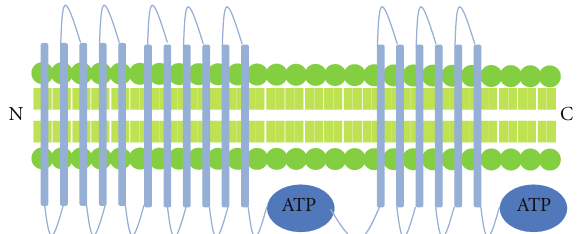
Figure 3: Structure of Multidrug Resistance Protein 1 (MRP1)— this ABC transporter is similar in structure to PGP in that they possess 2 ATP binding sites. In addition to the 12 transmem- brane domains, they also contain an additional 5 transmembrane domains at the amino terminal end. Other transporters with a similar structure include MRP2, MRP3 and MRP6.